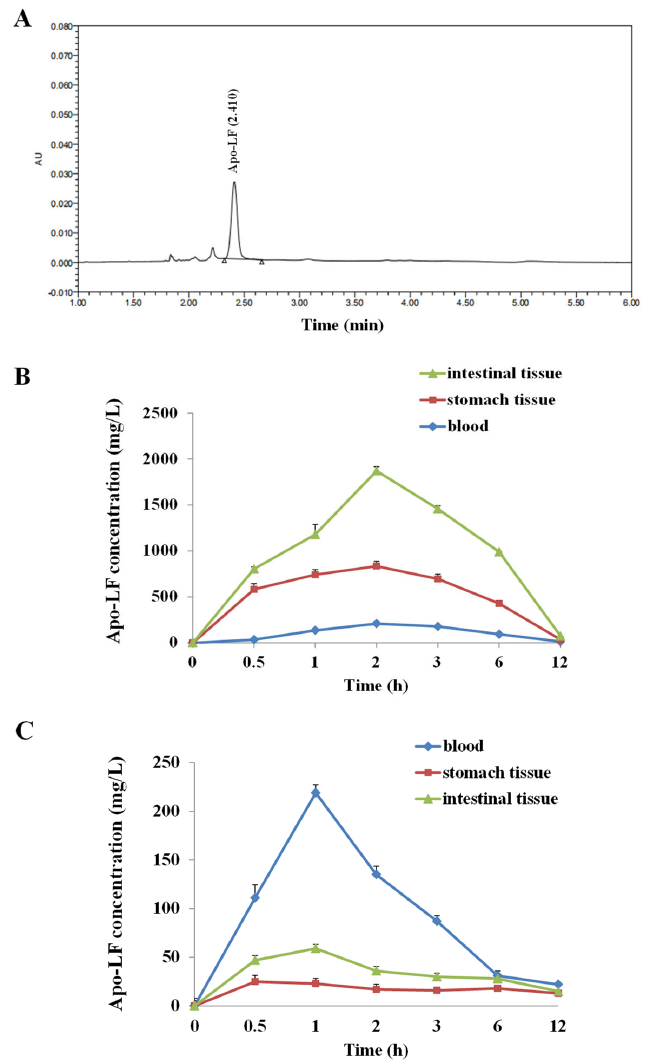
Figure 1. Pharmacokinetic analyses of Apo-LF. ( A ) Chromatogram of Apo-LF standard in testing solution from milk samples; ( B ) The concentration of Apo-LF in the intestinal tissues, stomach tissues and blood of mice after oral gavage; ( C ) The concentration of Apo-LF in the intestinal tissues, stomach tissues and blood of mice after intraperitoneal injection.